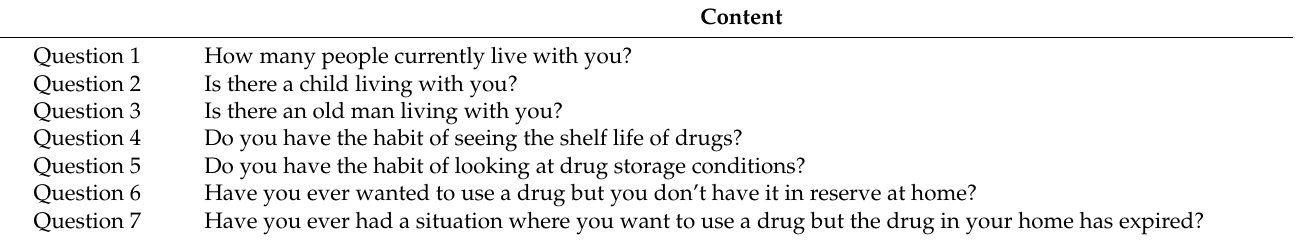
Table 2. Interview